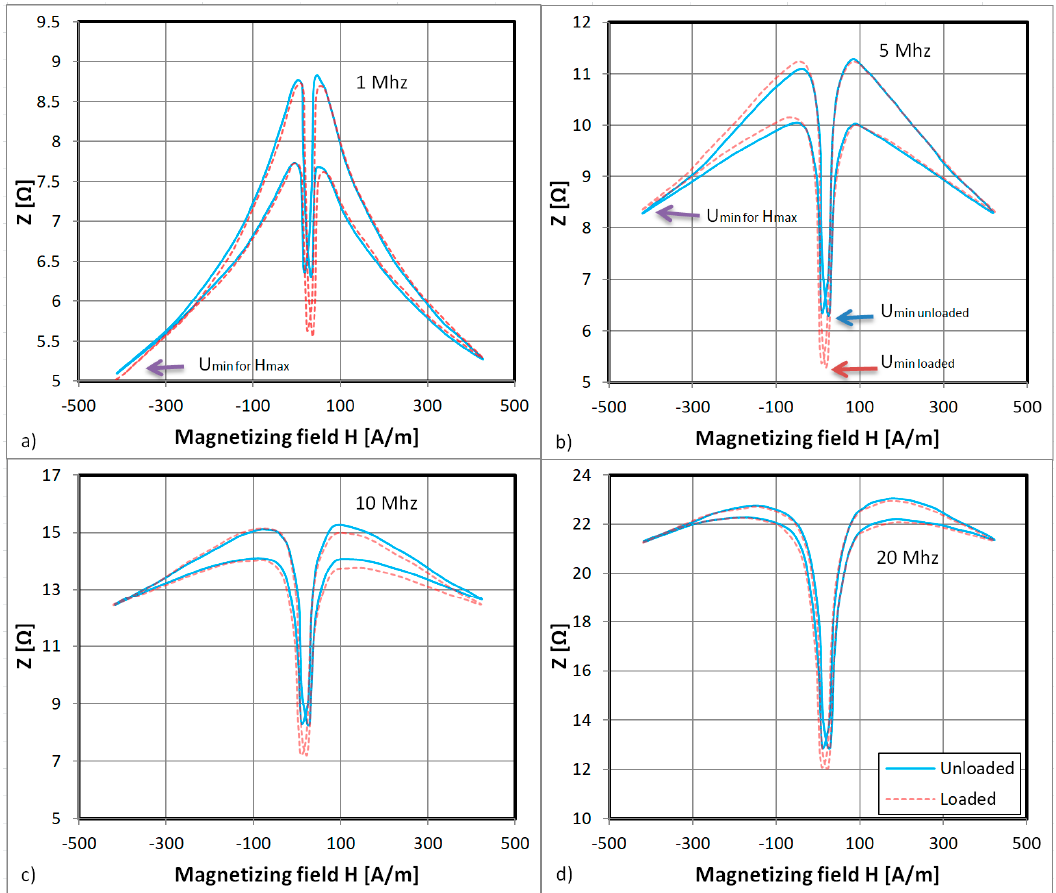
Figure 3. Dependence of sample impedance on the magnetizing field H applied longitudinally for ( a ) a 1 MHz driving signal; ( b ) a 5 MHz driving signal; ( c ) a 10 MHz driving signal; and ( d ) a 20 MHz driving signal. The blue line indicates the characteristic for zero strain and the red dashed line indicates the characteristic for fully applied strain. The blue and red arrows indicate the U min voltage drop minima for the strained and unstrained samples.